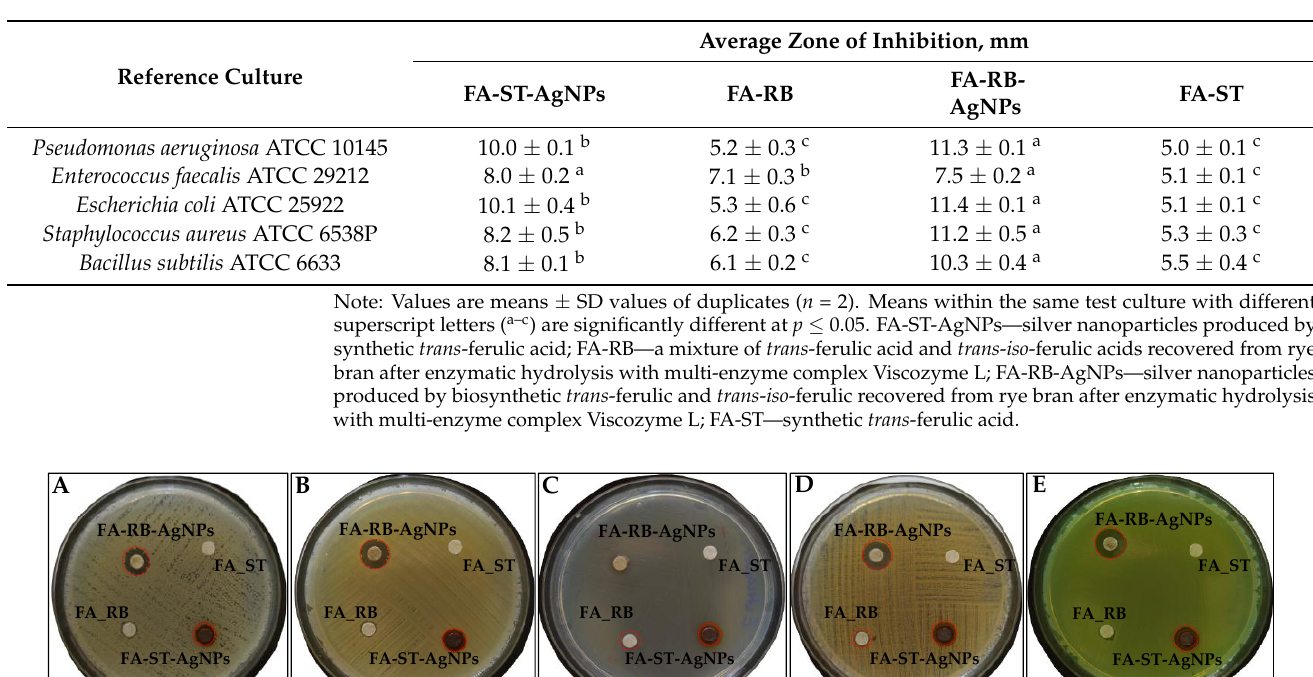
Table 5. Antimicrobial activity of silver nanoparticles according to diameter of the inhibition zone values. Average Zone of Inhibition, mm Reference Culture